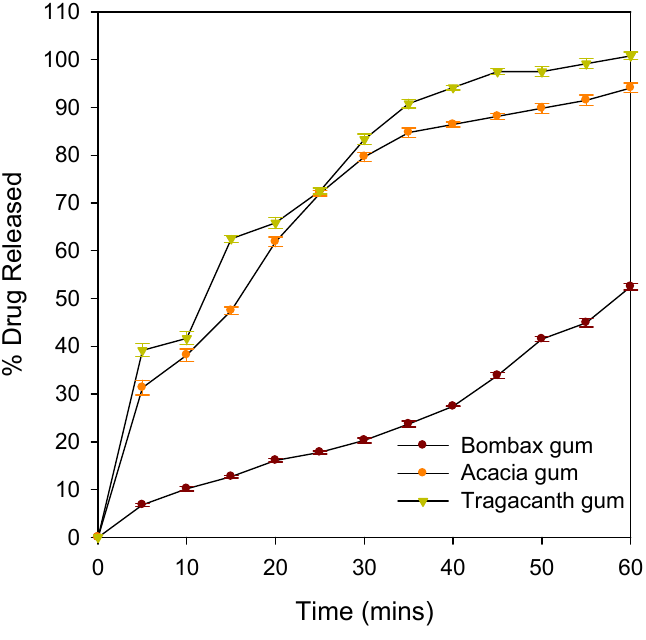
Figure 4. Drug release profiles of tablets formulated with bombax gum, acacia gum and tragacanth gum.